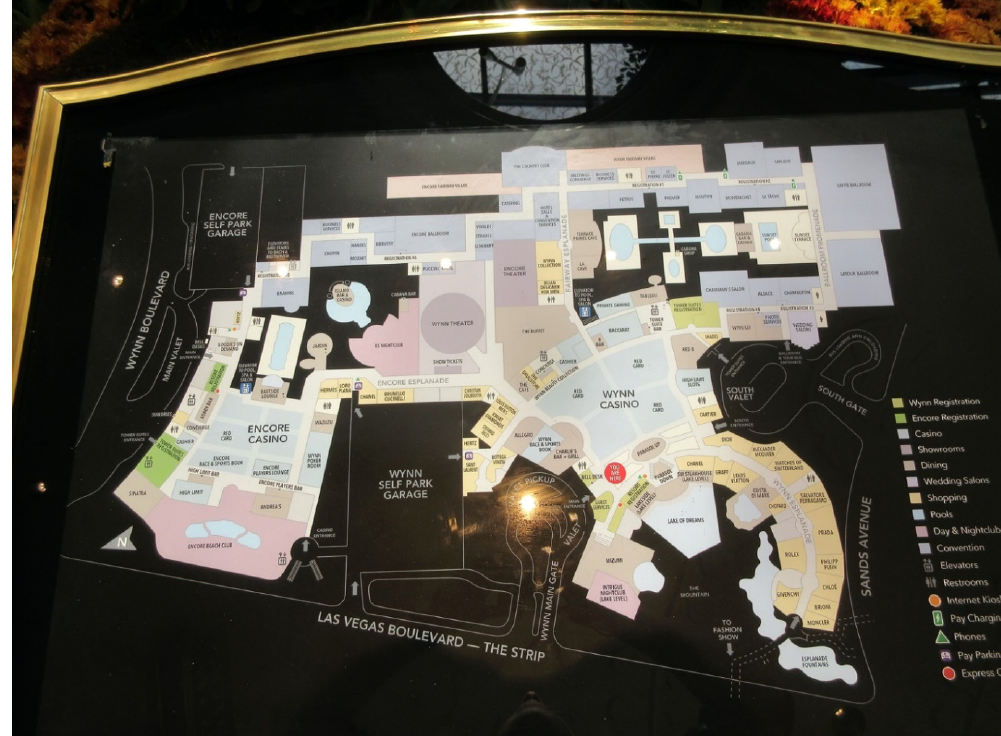
Figure 9. The full size and complexity of the facilities of Wynn Las Vegas casino‐hotel‐resort (along with its subsequent twin, Encore) can be grasped via this floor plan. Source: Aseem